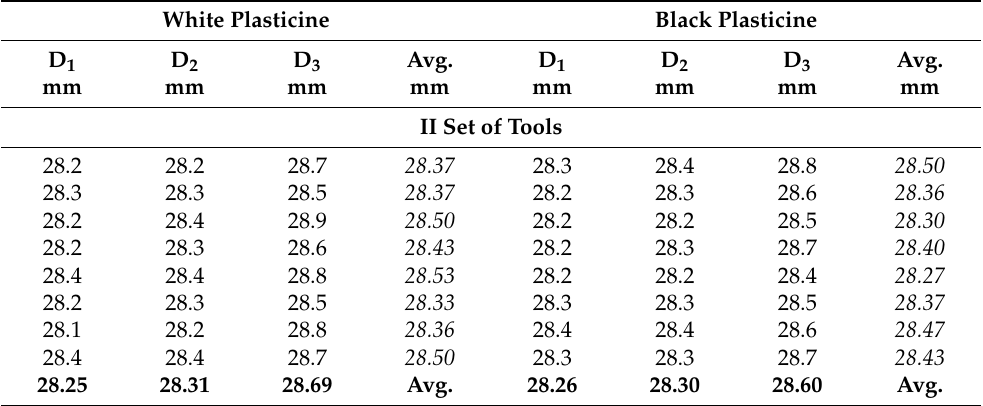
Table 6. Dimensions of model balls obtained by skew rolling—II set of tools: D1—groove diameter, D2, D3—average ball in two planes.